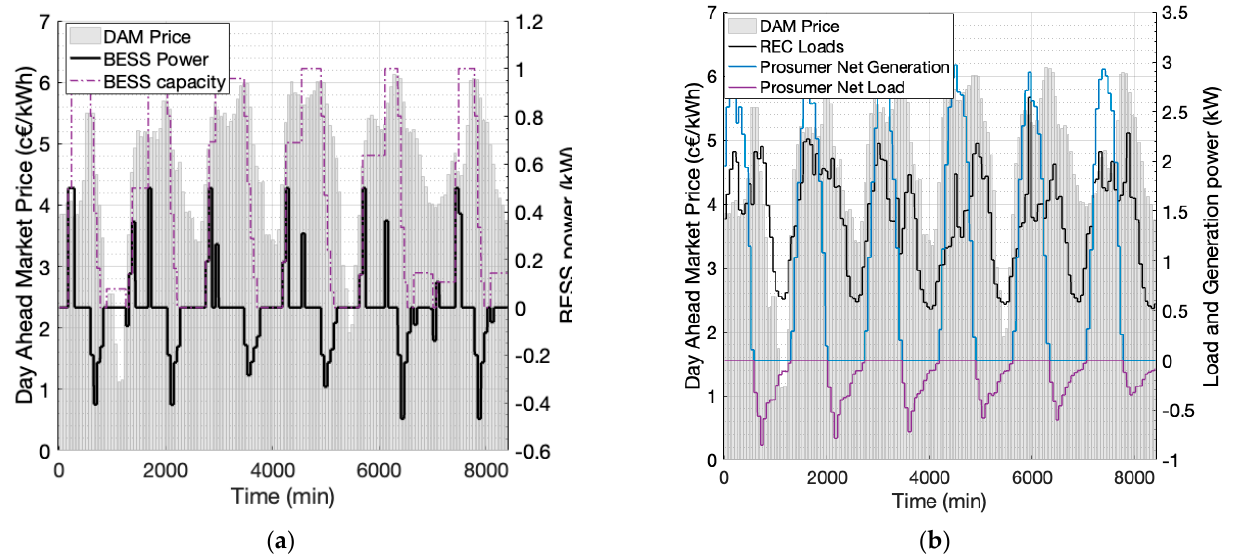
Figure 8. Extract of the BESS charge (positive) and discharge (negative) power curve (black) and corresponding BESS SoC curve (purple) ( a ); extract of forecasted REC loads (black) and prosumer net load (light blue) and generation (purple) curves ( b ). On the background of ( a , b ) the DAM prices. Both ( a , b ) are related to the same REC configuration and to the same 6-days period.